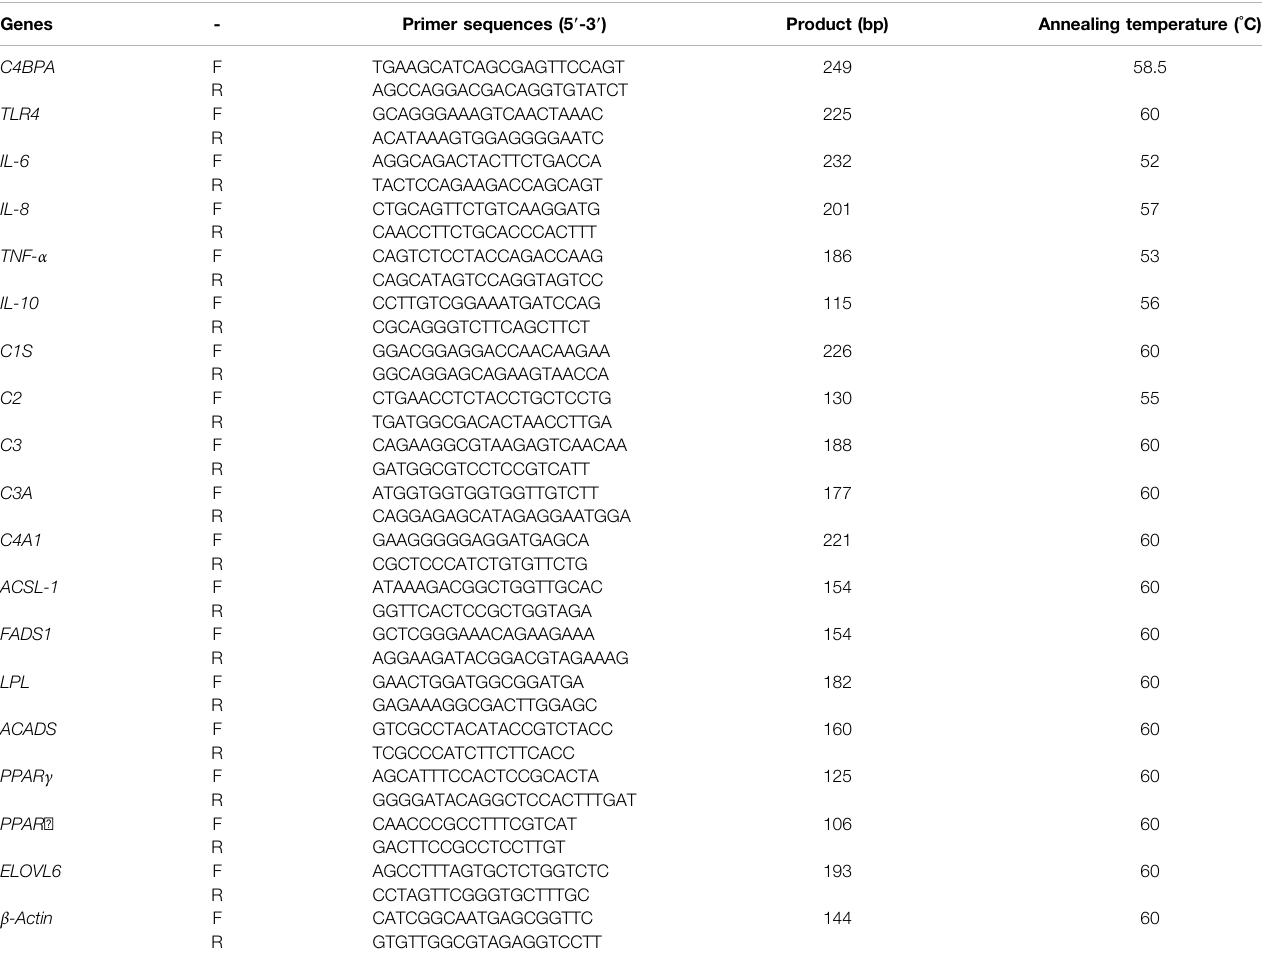
TABLE 2 | List of primer sequences used for